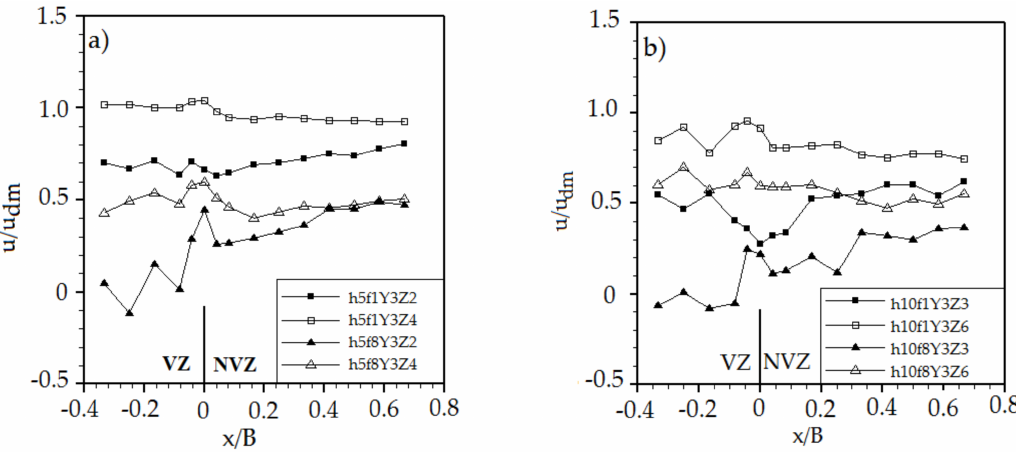
Figure 8. Non-dimensional streamwise velocity distributions at Y3 line along the streamwise direction for different SVFs, ( a ) h v 1 = 0.05 m; ( b ) h v 2 = 0.10